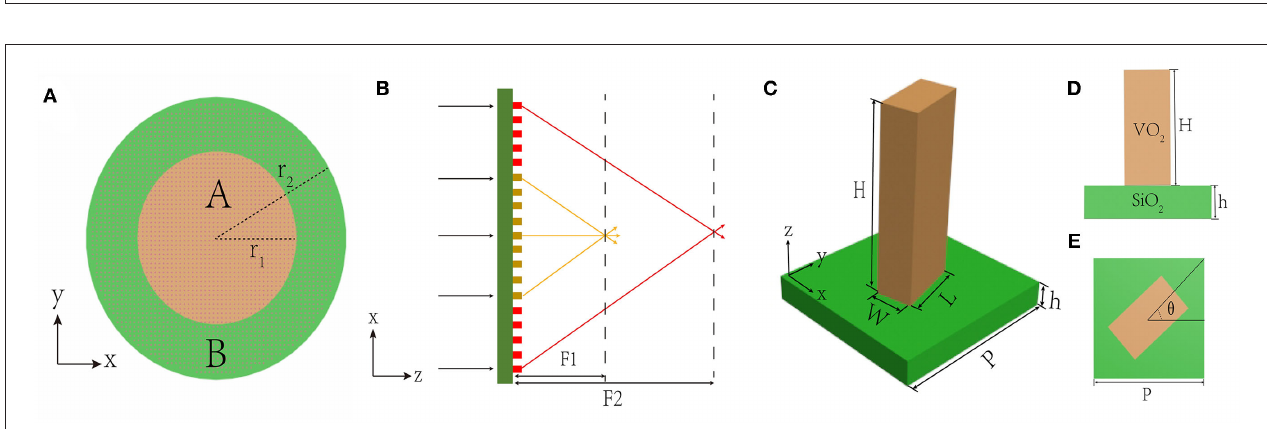
P. The required phase is imparted by rotation of the nanofin by an ×